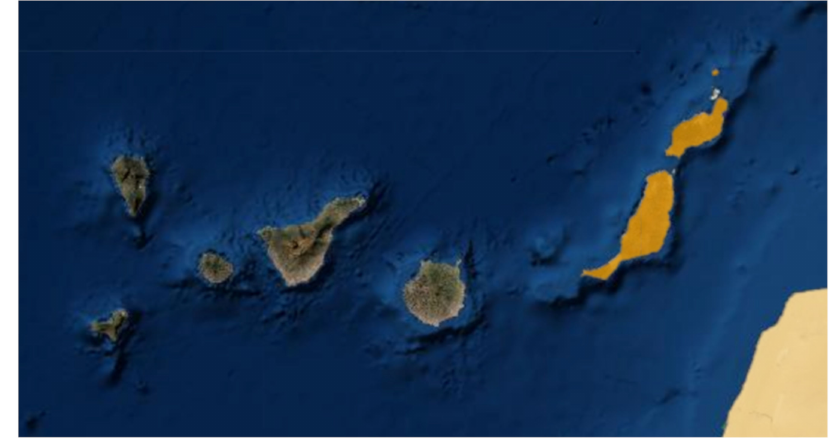
Figure 1. Canarian Egyptian vulture inhabits only two islands (Fuerteventura and Lanzarote) of the Canary Island Archipelago. (From: Leaflet | Powered by Esri | Esri, HERE, Garmin, FAO, NOAA,